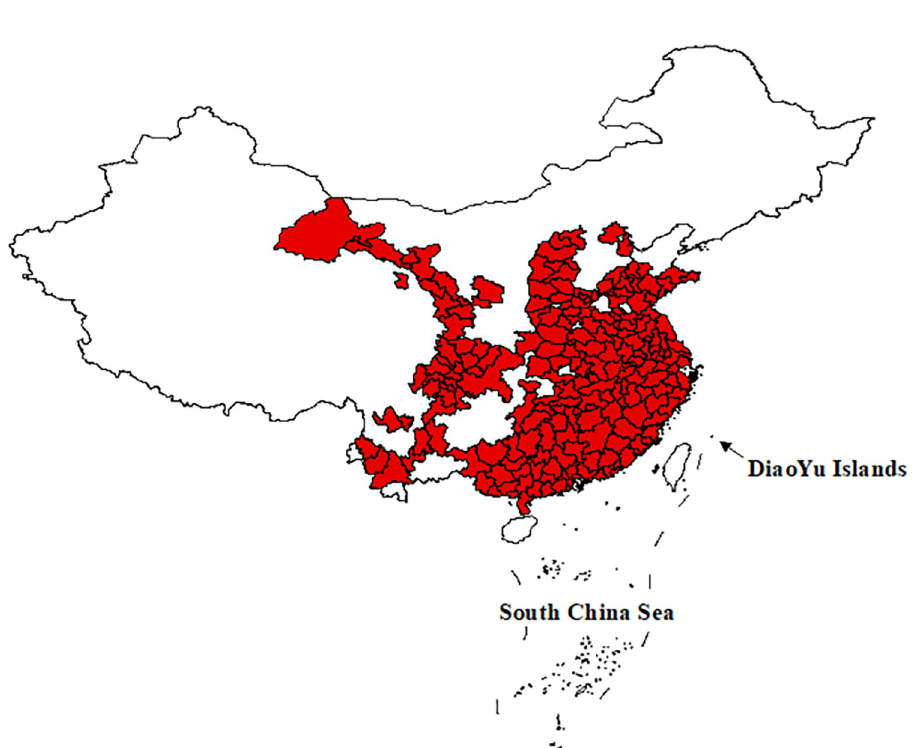
Fig 1. The 202 cities in China studied in this